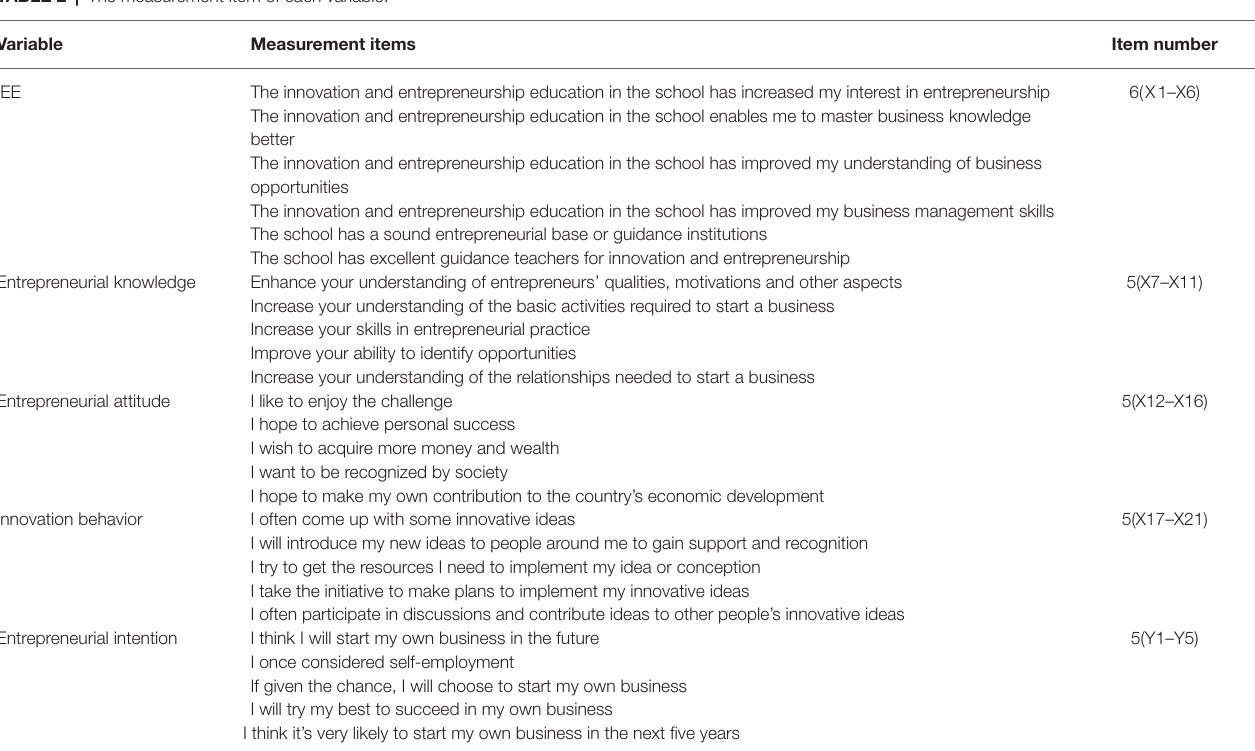
TABLE 2 | The measurement item of each